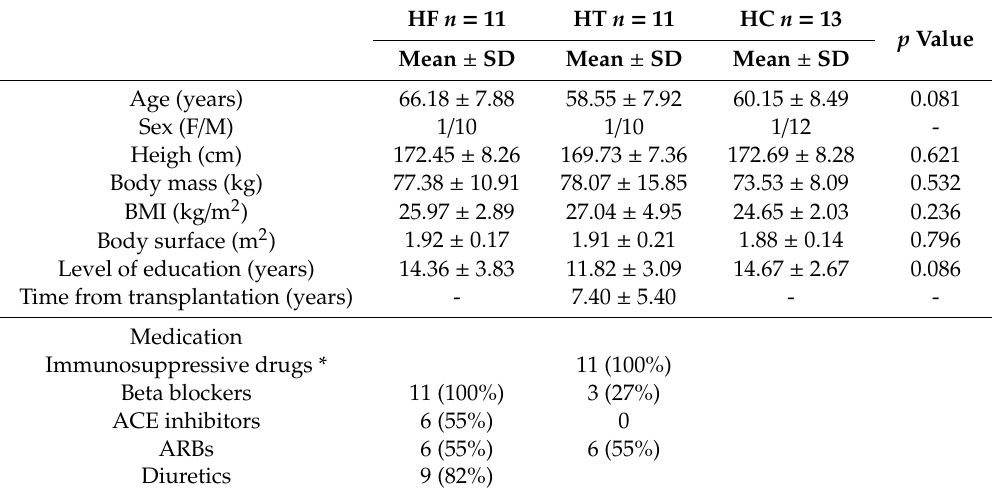
Table 1. Baseline clinical and sociodemographic characteristics in healthy controls (HC), heart failure patients (HF) and heart transplant recipient (HT)